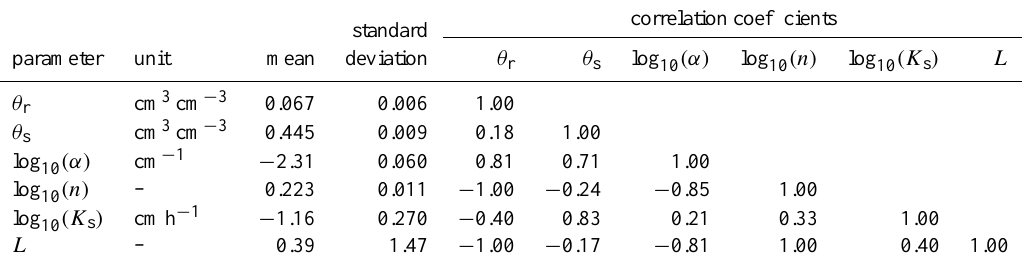
Table 2. Mean values, standard deviations, and correlation coefficients of the ROSETTA (Schaap et al., 2001) predicted soil hydraulic parameters.